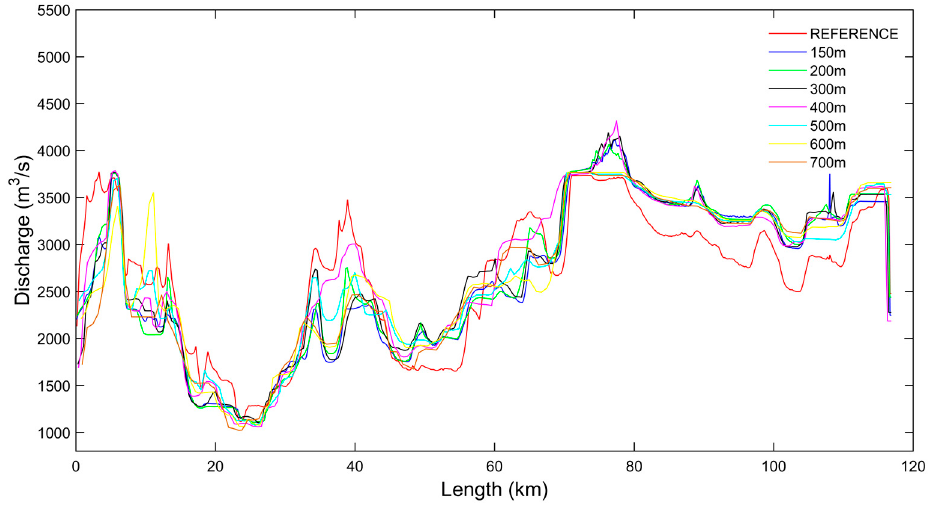
Figure 6. River channel flow profile with simulated maximum peak discharge at 150 m and coarser resolutions.